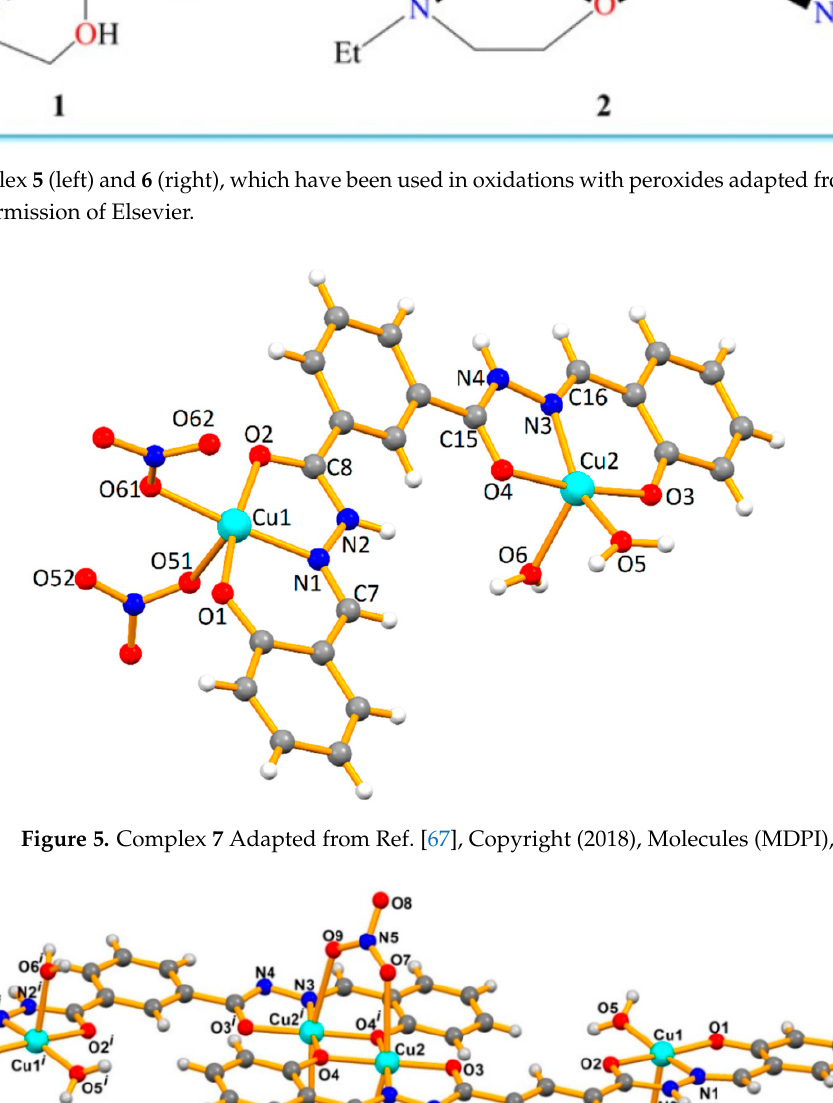
Figure 4. Formulae Complex 5 (left) and 6 (right), which have been used in oxidations with perox- ides adapted from Ref. [64], Copyright (2011) with permission of Elsevier.